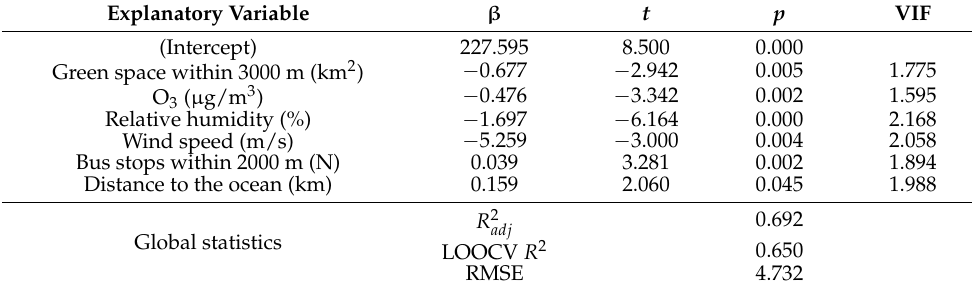
Table 6. Final results of the NO 2 model for nighttime (7 p.m.–7 a.m.).